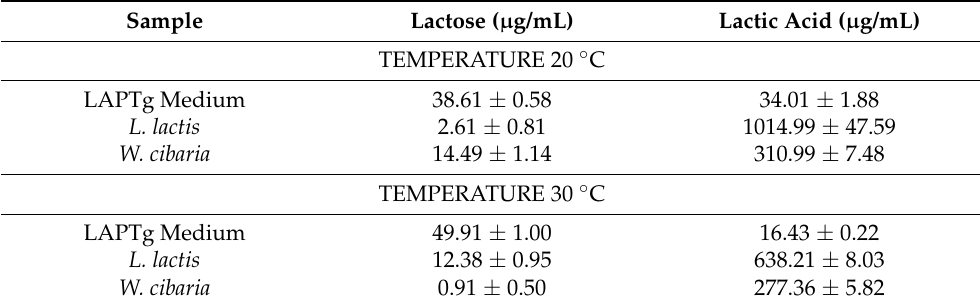
Table 7. Concentration of the analyzed compounds in the LAPTg medium and the post-culture fluid of LAB strains obtained using HPLC analysis. During the analysis, the concentrations of the analyzed lactose and lactic acid in the clean medium were taken into account (values for LAB strains shown in the table are after background